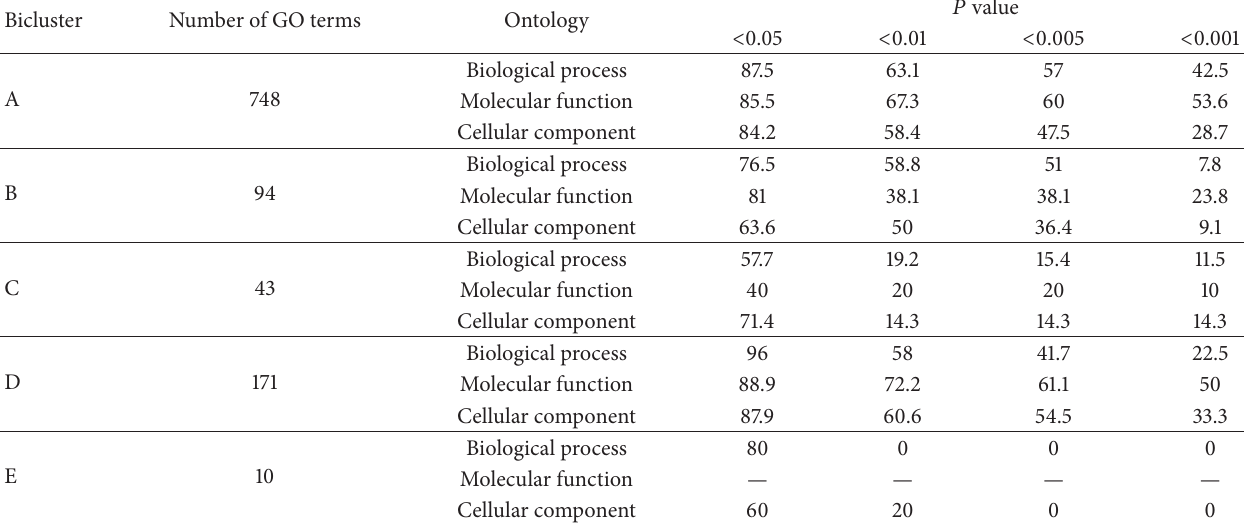
Table 4: Biological significant of biclusters